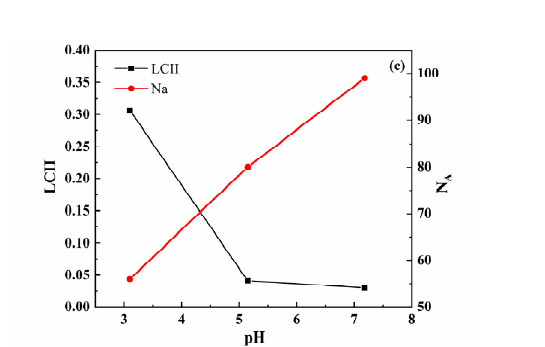
Figure 6. S8-coated electrode statistical and calculated results for ( a ) the sum of anode current density i tot , ( b ) the maximum anodic current density i max , ( c ) the localized corrosion intensity index L CII, and the number of anodes N A .